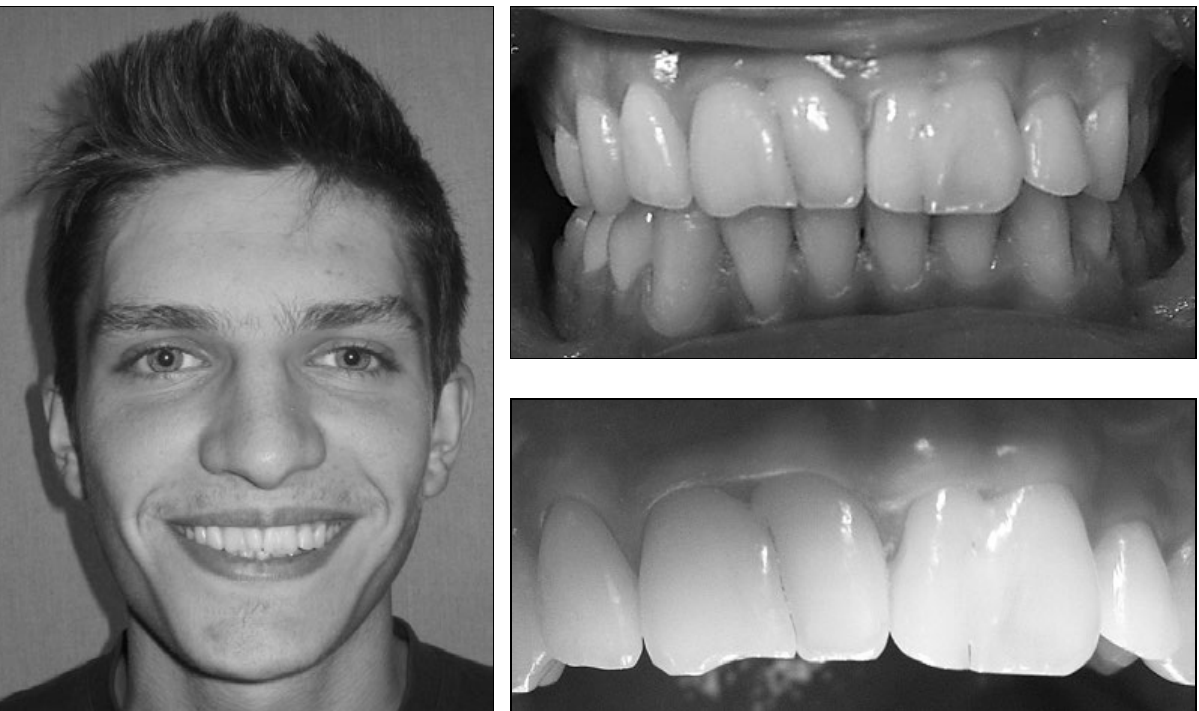
Figure 6, 7, 8. Pre-prosthetic extra- and intraoral frontal